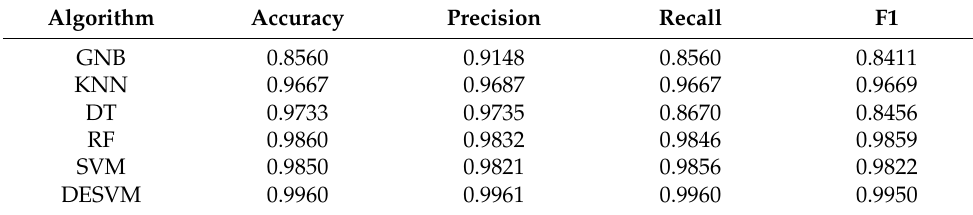
Table 2. Comprehensive performance of each machine learning model.